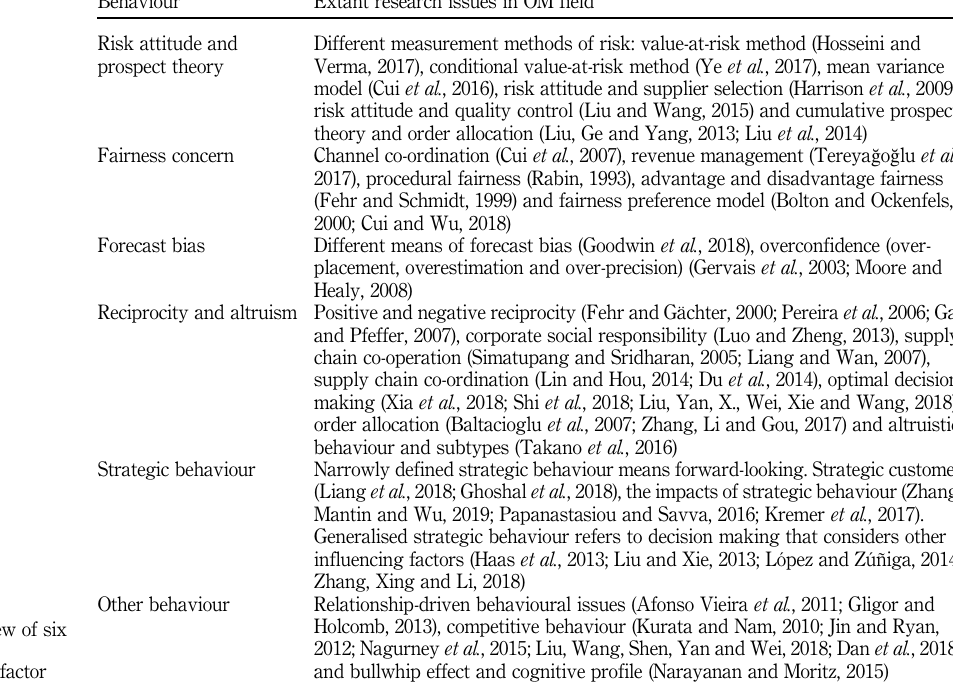
Table VII. A brief review of six subtypes of behavioural